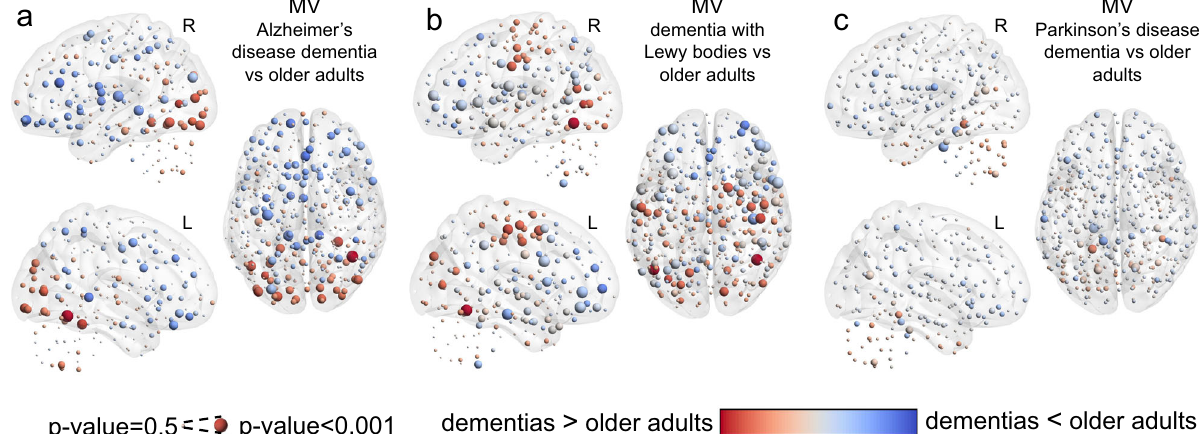
Fig. 6 Neurodegenerative dementia effects of modular variability (MV). a MV differences between older adults (OA) and Alzheimer ’ s disease dementia (ADD). b MV differences between older adults (OA) and dementia with Lewy bodies (DLB). c MV differences between older adults (OA) and Parkinson ’ s disease dementia (PDD). Results were assessed with non-parametric permutations (5000) after regressing out covariates of no interest. Results for MV- PDD were not signi fi cant (uncorrected) while the rest of the comparisons showed signi fi cant uncorrected results.